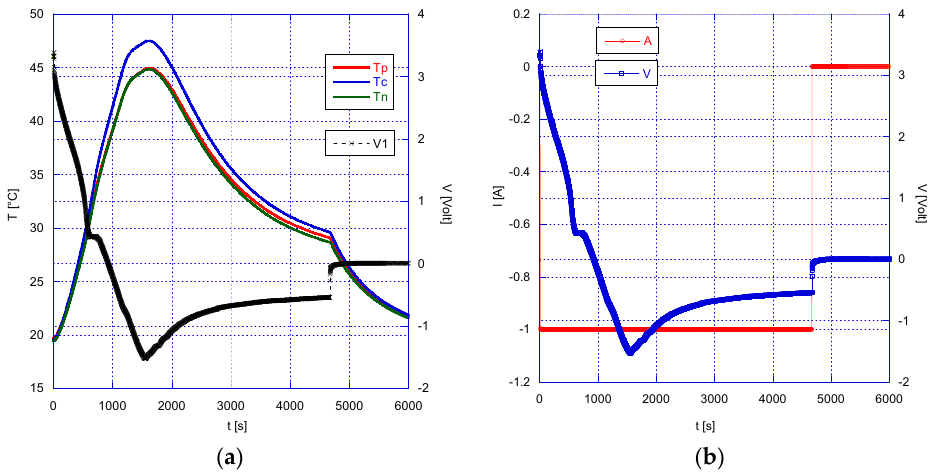
Figure 7. Graphite anode cells. Overdischarge test, DOD% = 140%: ( a ) temperature and voltage trend of the abused cell, ( b ) current and voltage trends of the abused cell.